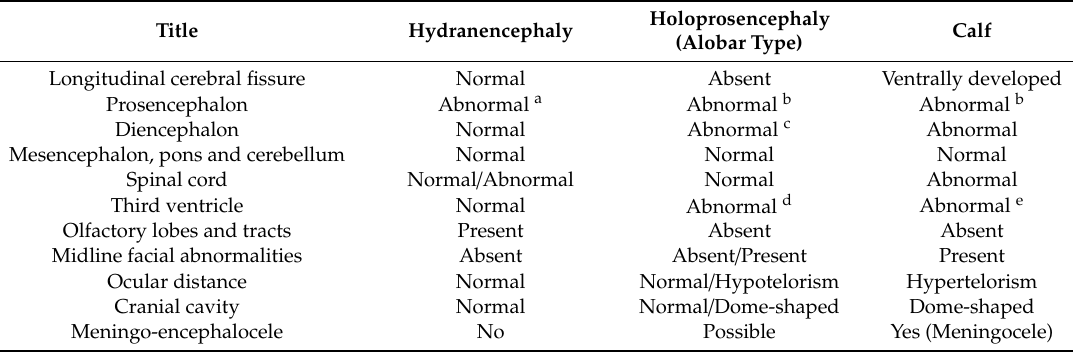
Table 1. Neuropathological features of hydranencephaly, holoprosencephaly, and the brain of the calf described